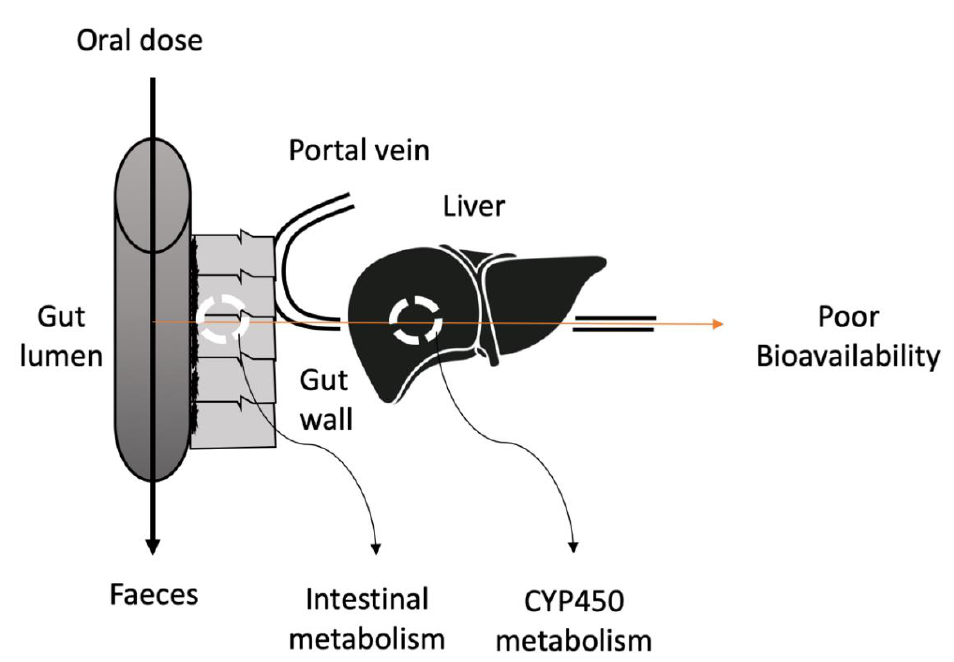
Figure 1. Schematic diagram depicting the route of poor bioavailability after oral administration of the drugs .